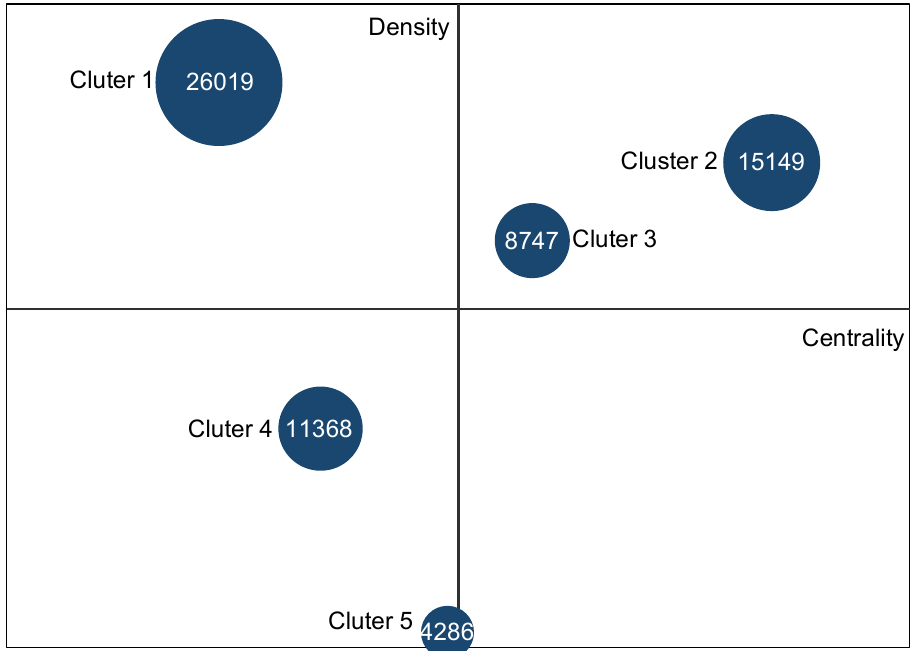
Figure 5. Strategic diagram based on number of times the papers was cited.